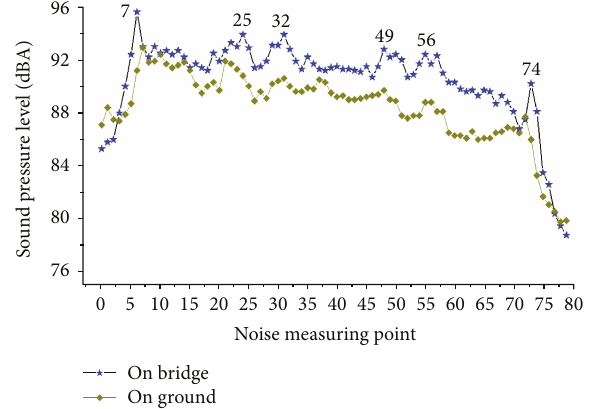
Figure 13: Comparison of aerodynamic noise levels under di ff erent road